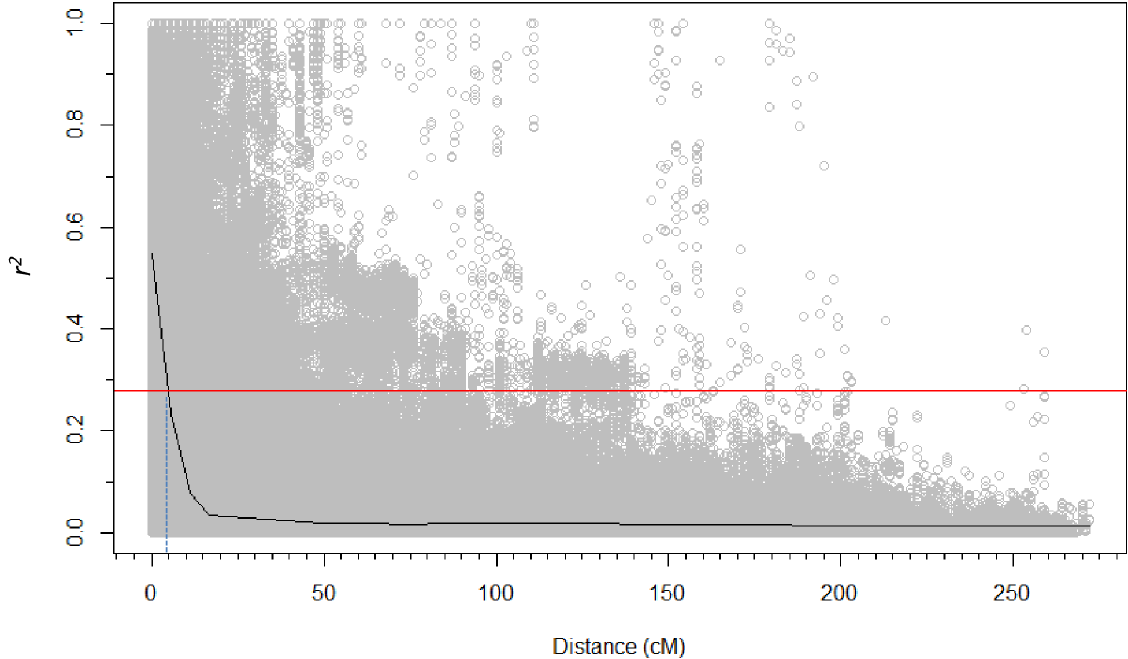
Fig 2. Linkage disequilibrium (LD) decay plot for the Northwest elite spring wheat panel (n = 395). The 95th percentile of r 2 (0.28) is shown by the red line. The blue dotted line indicates the intersection between critical r 2 and the map distance to determine QTL confidence